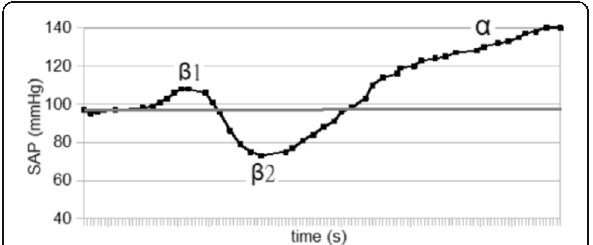
Fig. 4 (abstract A16). Etilefrine without interaction